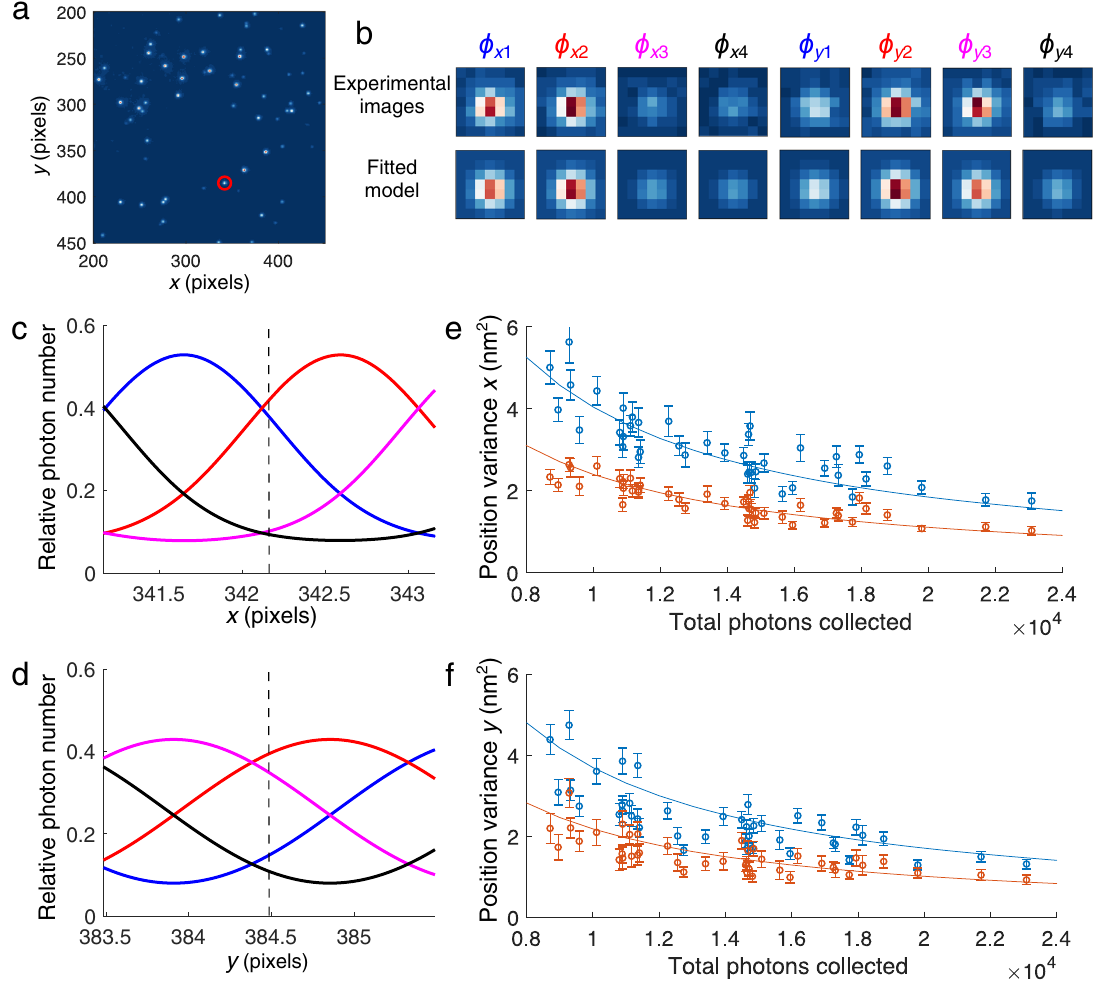
Fig. 4 Experimental demonstration of C-MELM with non-harmonic structured illumination. a Camera-based microscopy image of a sample containing multiple isolated fl uorescent 51-nm beads (Methods). Effective pixel width, 107nm. A bead used as example for demonstration in subsequent panels is indicated (red circle). b The sample in a was subjected to eight 50-ms exposures of structured illumination (Methods): four phases of x -periodic illumination ( ϕ x ) and four phases of y -periodic illumination ( ϕ y ). This resulted in eight recordings of diffraction-limited spots (top row) from the same bead, which constitute one measurement. The fl uorescent bead ’ s position and eight intensities were estimated by a simultaneous maximum likelihood estimation fi t of eight model point-spread functions with shared point-source location, in which we constrained the relative intensities in spots as expected from the illumination structures (bottom row, Methods). c , d Relative photon numbers expected from the characterization of four phases of structured illumination (solid lines with various colors, Methods, Supplementary Note 9, Supplementary Fig. 9) along the x - ( c ) and y -axes ( d ), respectively. The bead ’ s approximate position is indicated (dashed lines). e , f Sample variance of position estimates, for x- ( e ) and y- coordinates ( f ), for all 40 isolated particles in the fi eld of view in a for C-MELM (orange) and conventional camera-based localization (blue). Error bars represent the s.d. of the sample variance. The information- theoretical lower bound (Cramér-Rao lower bound (CRLB), Supplementary Note 8) for the variance is indicated for both methods (solid lines). C-MELM achieves its lower bound and is uniformly the superior method as it has the smaller variance, corresponding to an N effective larger by a factor ~1.7 (Eq.